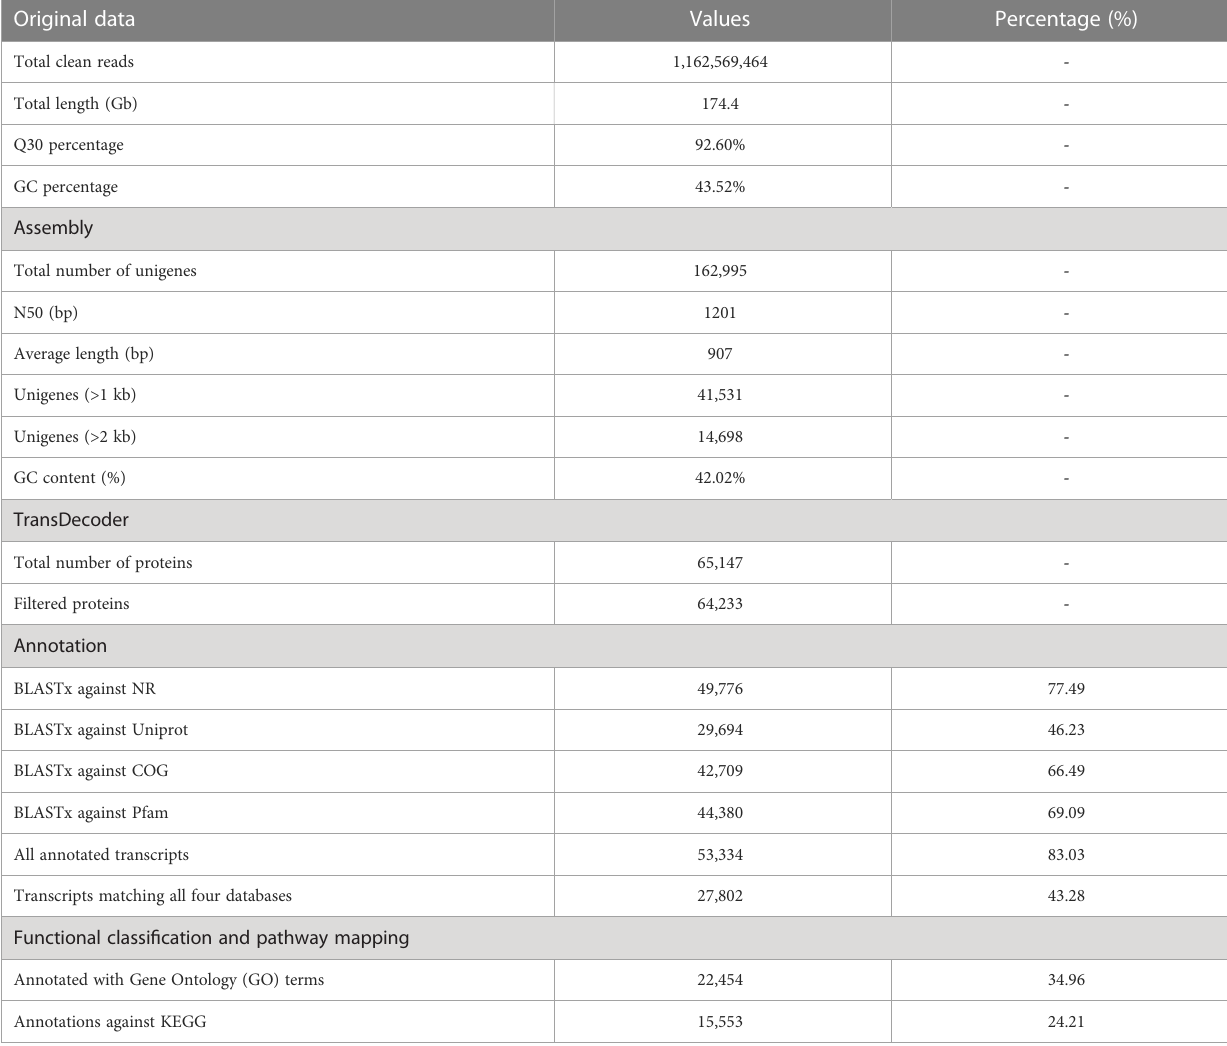
TABLE 1 Summary of sequencing data, assembly and function annotation of the R. sanguineum var. haemaleum